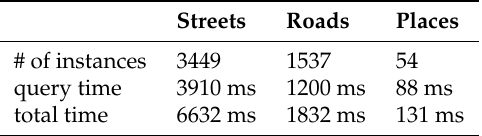
Table 2. The number of instances and the retrieval time for each feature